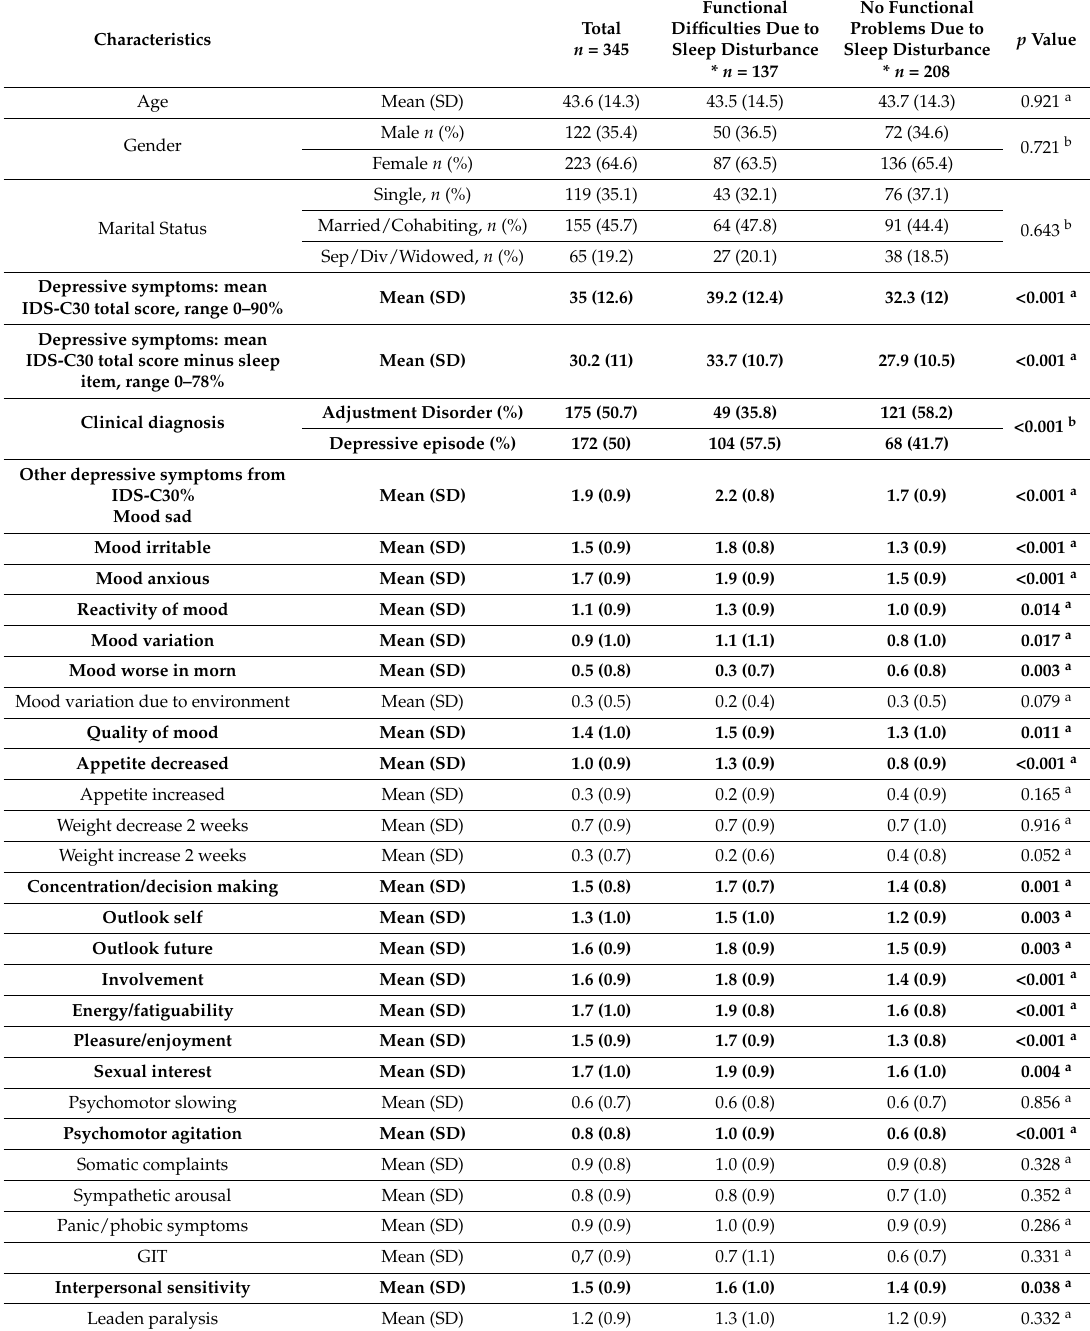
Table 3. Demographic and clinical characteristics of patients divided by disturbance in function attributed to sleep